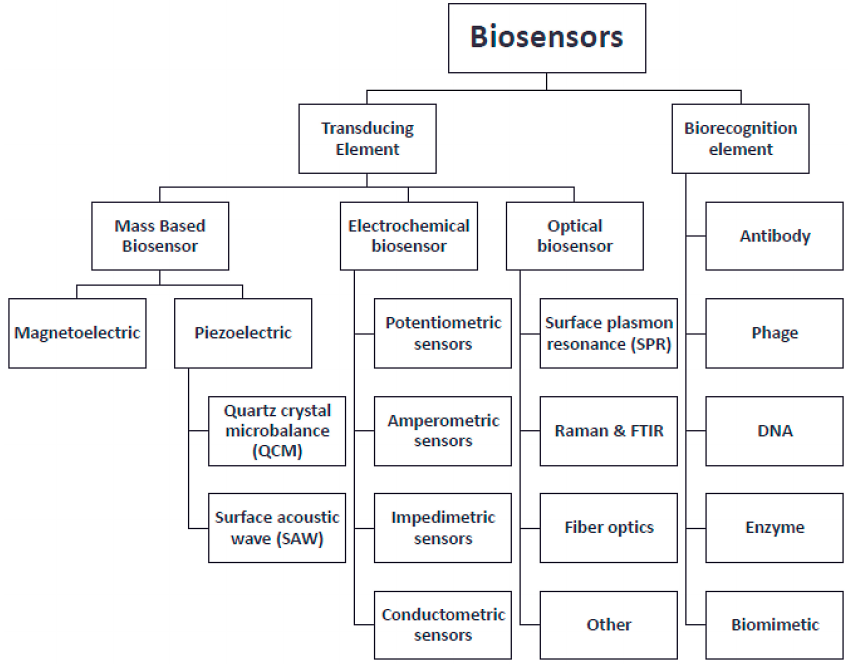
Figure 1. Classification of biosensors based on transducer and bio-recognition elements used in food analysis [10].